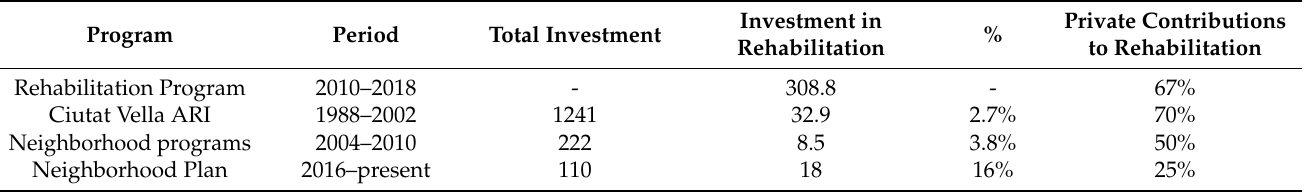
Table 3. Public investment: in total and in private rehabilitation initiatives. Data provided in millions of euros. Program